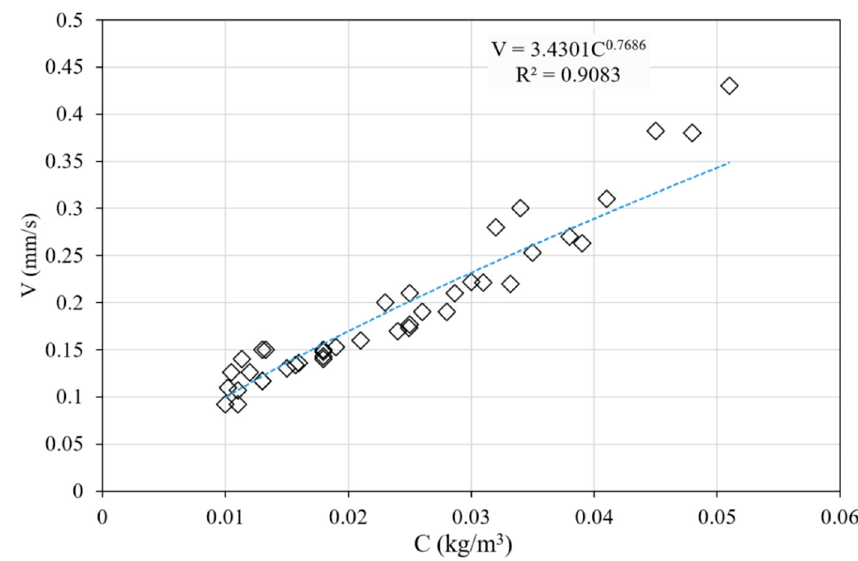
Figure 5. Variation of the settling velocity with SSC on the Lobo